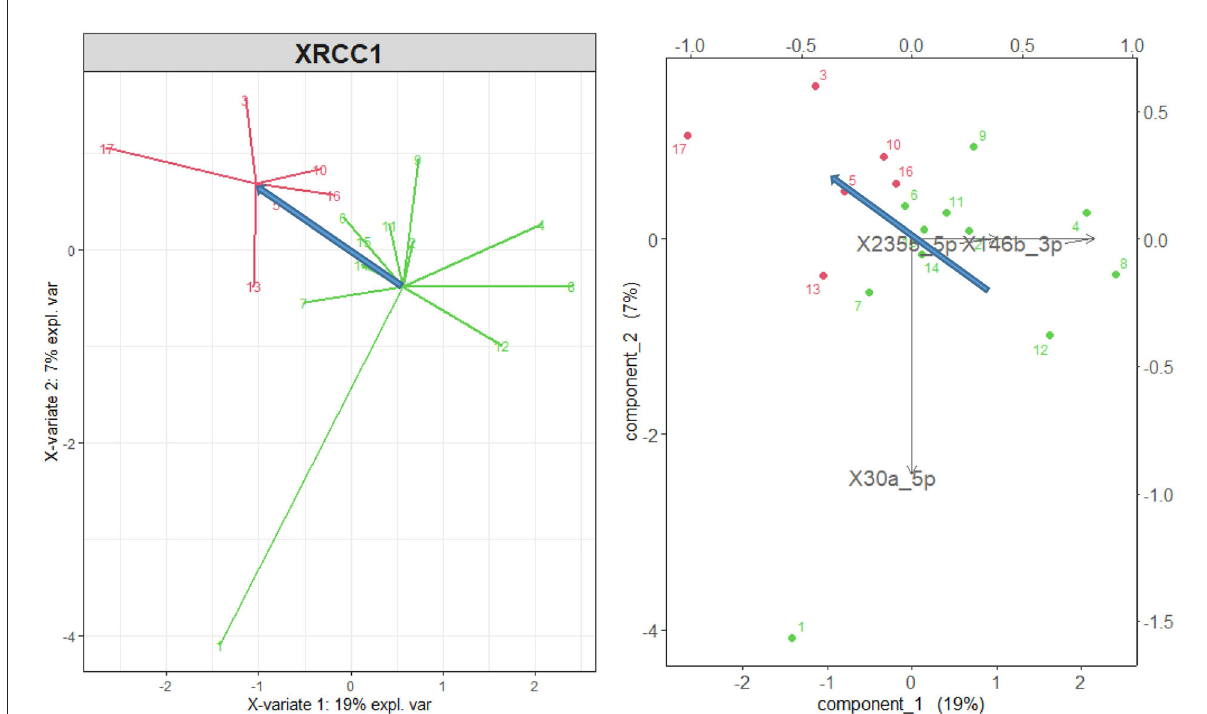
FIGURE4 sPLS-DA wt and mut variants of the gene XRCC1 (green points and arrows) vs. het variant (red). Right: representation of the original variables in the 2d space of the transformed variables. The microRNA with a correlation higher than 0.75 are shown. The blue arrows represent the direction of maximal discrimination between the two